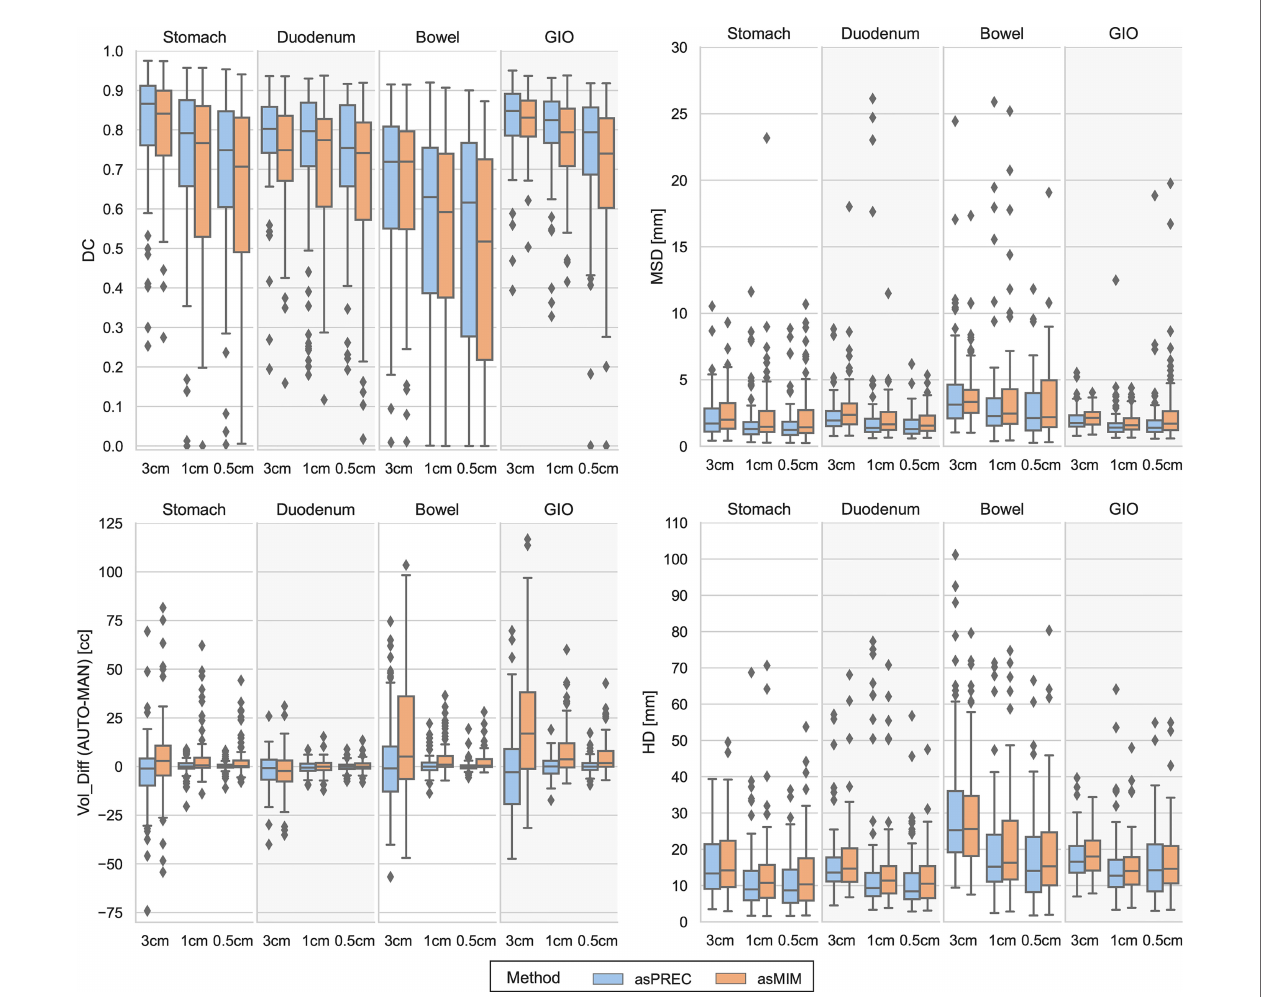
FIGURE 2 | Boxplots showing the differences between Dice coef fi cient (DC) [top left], mean surface distance (MSD) [top right], volumetric difference between auto vs. manual contours (VOL_DIFF) [bottom left] and Hausdorff distance (HD) [bottom right] for structures autosegmented with Precision (asPREC in blue) and MIM (asMIM in orange). Each column of each sub fi gure distinguishes the boxplots on each structure (stomach, duodenum, bowel and GIO) and for each organ, distributions are separated for the clipped structures at 3, 1 and 0.5 cm from the